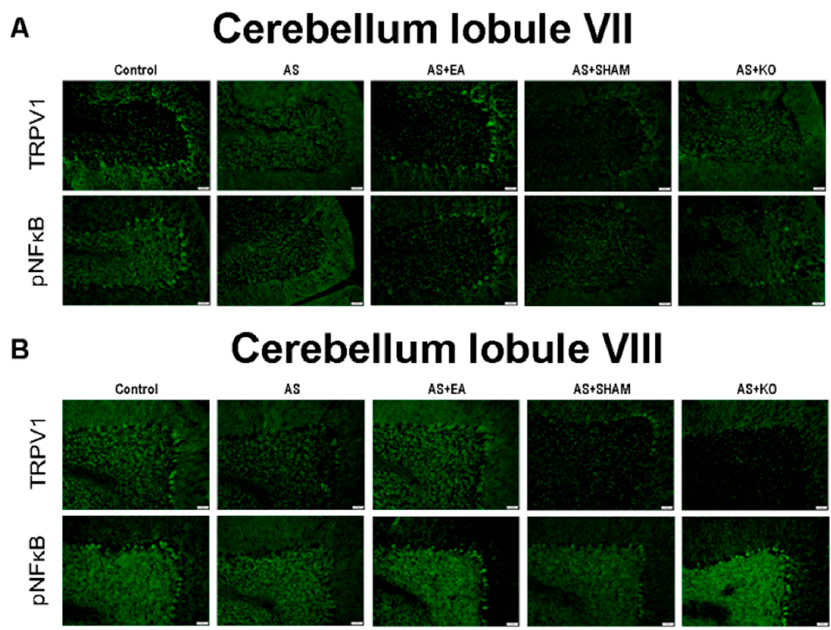
Figure 6. Immunofluorescence staining of TRPV1 and pNFkB protein expression in the cerebellum lobules VII and VIII. There are 5 subject groups: Control, AS, AS + EA, AS + SHAM, and AS + KO.